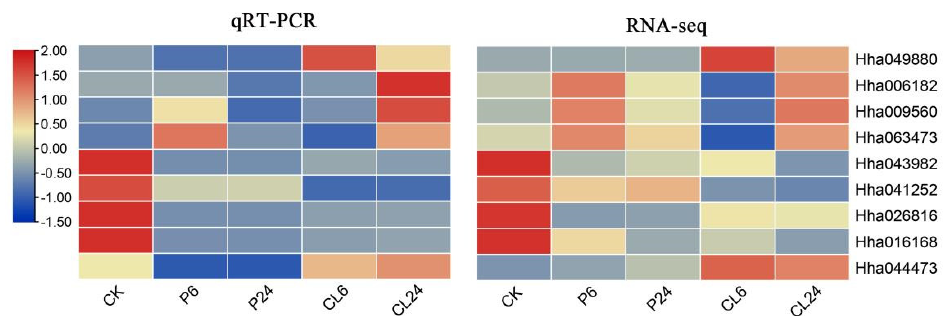
Figure 2. Verification of the expression level of the randomly selected genes obtained from RNA-Seq using qRT-PCR. The heat map indicates the expression patterns (log 2 ratio) under different stress treatments for each gene as measured by RNA-Seq and qRT-PCR.